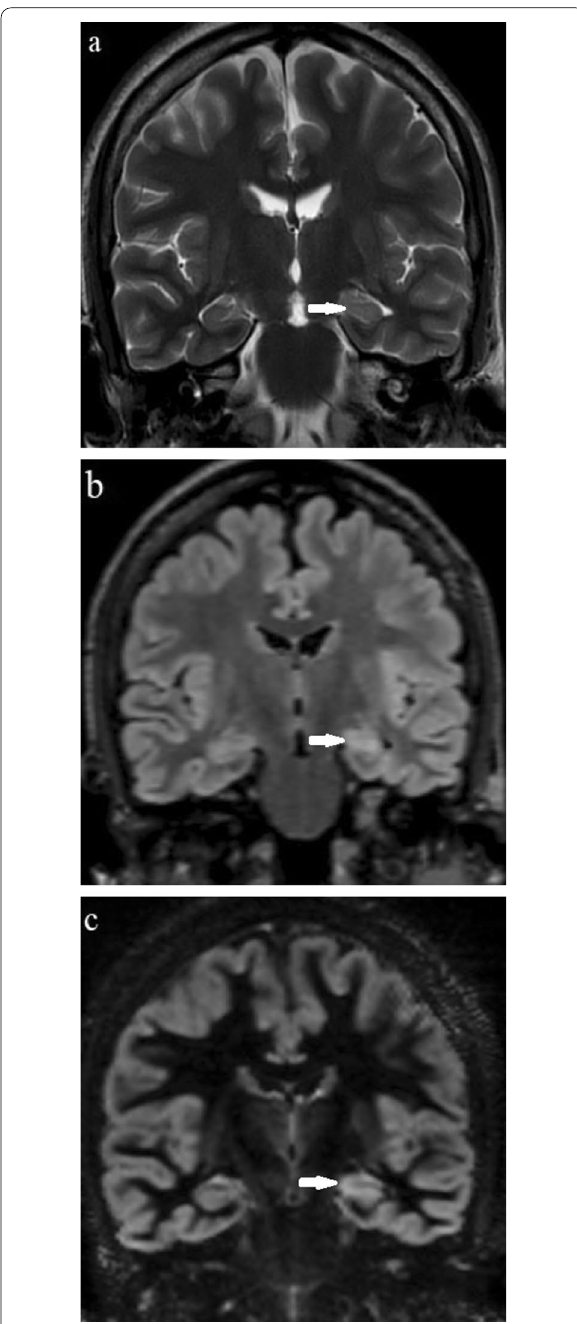
Fig. 1 Left mesial temporal sclerosis in an 18 years old female patient. Oblique coronal T2 weighted ( a ), FLAIR ( b ) and DIR ( c ) images. The left hippocampus is atrophic showing hyperintense signal in T2 (arrow in a ), FLAIR (arrow in b ) and in DIR (arrow in c ). Asymmetry of signal intensity of the hippocampi is most conspicuous on the DIR image